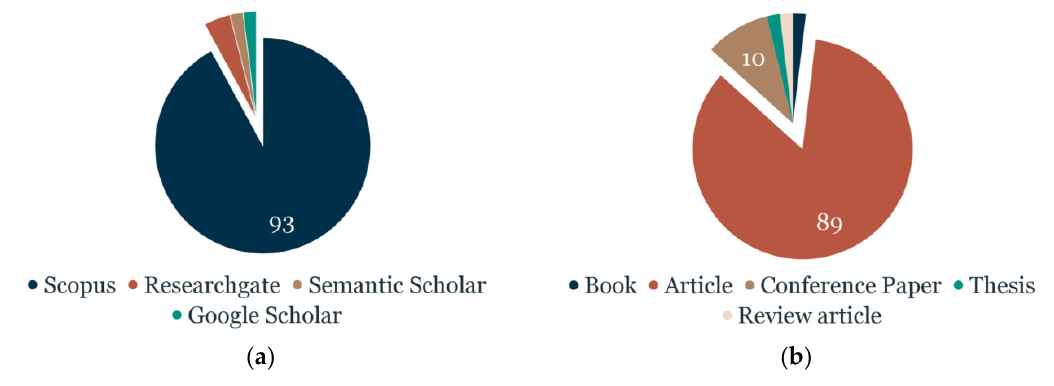
Figure 3. The sources of the academic papers ( a ) and types of documents in the review lists ( b ).